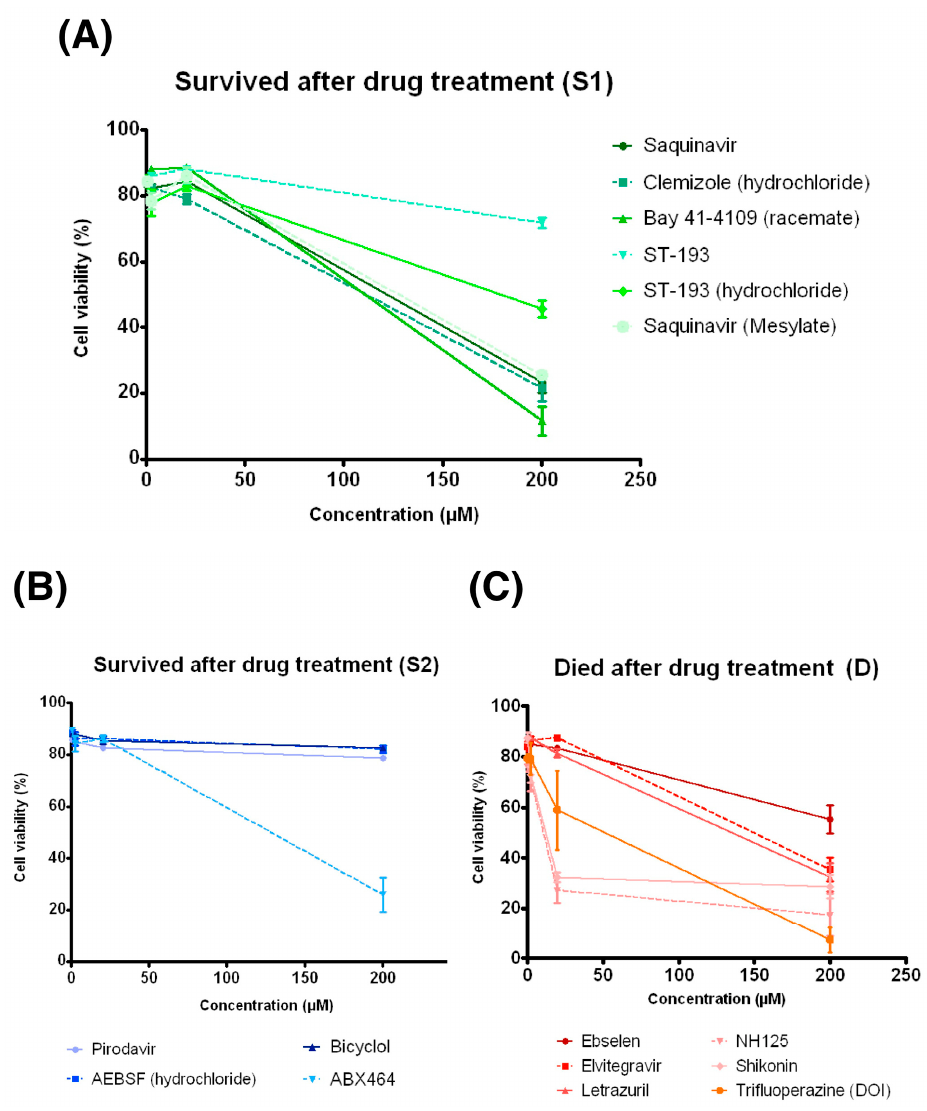
Figure 5. LDH results in 16 compounds in THP-1 cells. ( A ) Cell viability after being treated with drugs in the S1 group. ( B ) Cell viability after being treated with drugs in the S2 group. ( C ) Cell viability after being treated with drugs in the D group. Data are presented as means ± SD ( n =